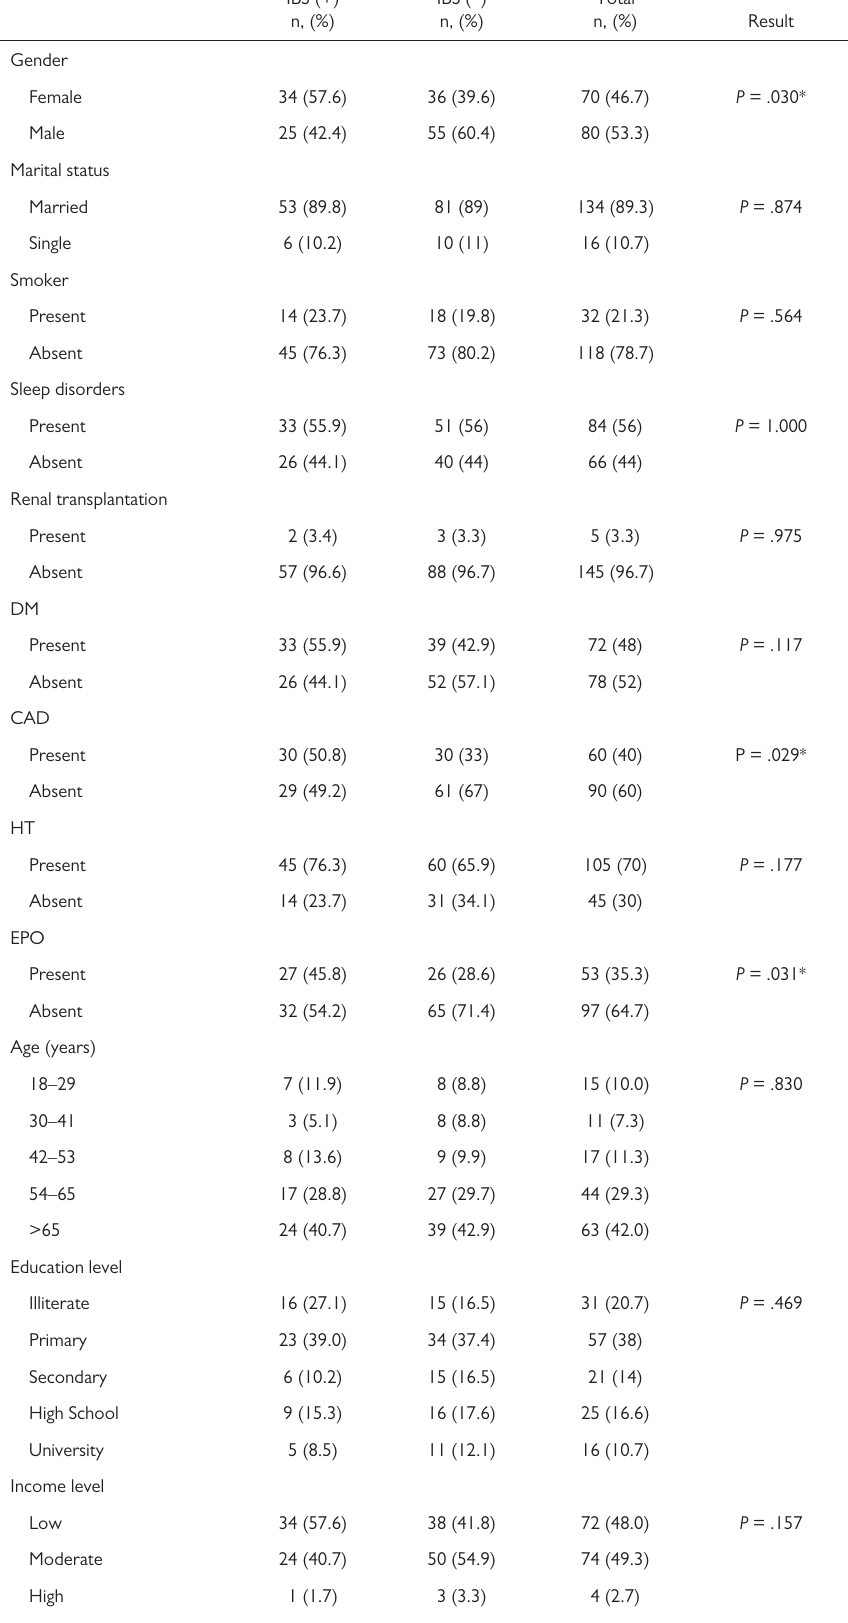
Table 2. Patients ’ Sociodemographic and Clinical Characteristics according to Presence of